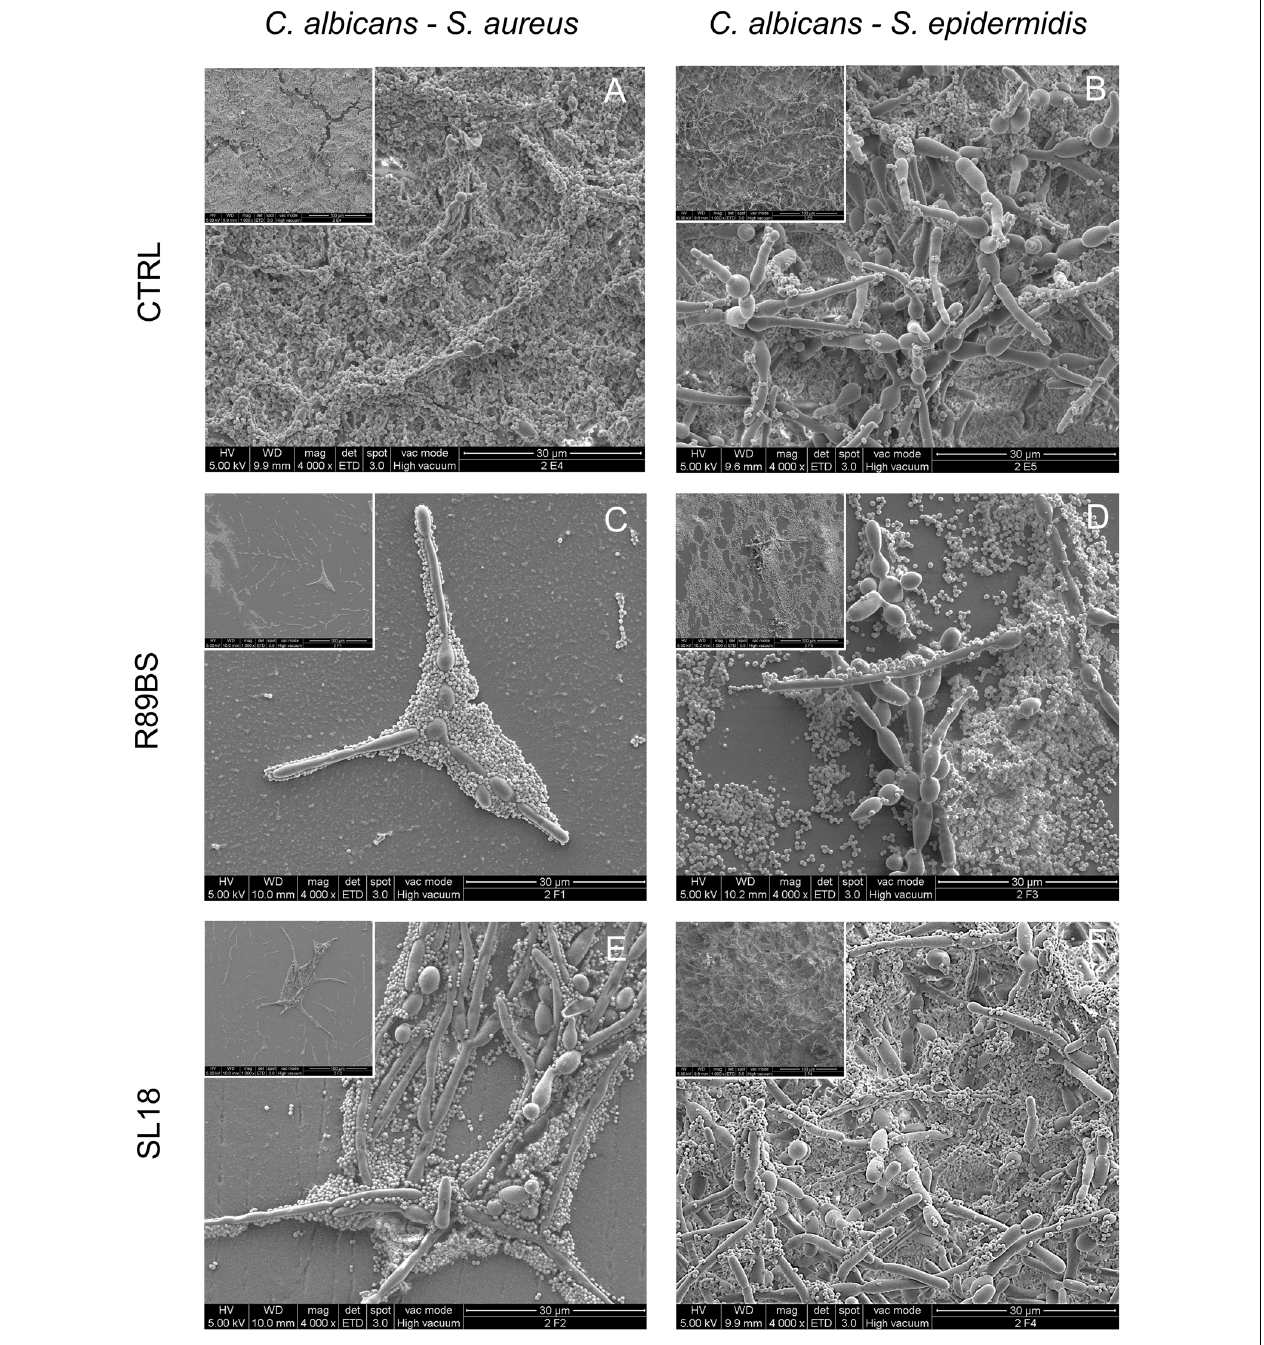
FIGURE 8 | Scanning electron microscopy images of the dual-species biofilms formed on the silicone discs surface at 72 h. C. albicans – S. aureus on the left column and C. albicans – S. epidermidis on the right column. Different surface pre-coating treatments are presented: untreated controls (top row), rhamnolipid R89BS (middle raw), and sophorolipid SL18 (bottom row) treated discs. Insets present a lower magnification of the corresponding image to appreciate both macrostructural arrangement of the biofilm on the surface and micro-structural architecture of the two species in each biofilm sample. Original magnification: 4000x (1000x for the